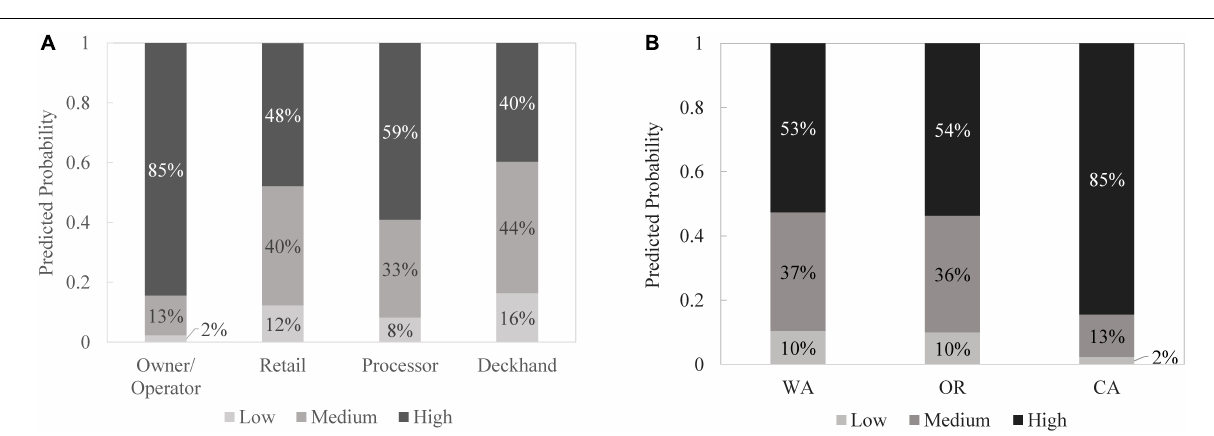
( Supplementary Tables A4, A5 and Figure 3 ). As